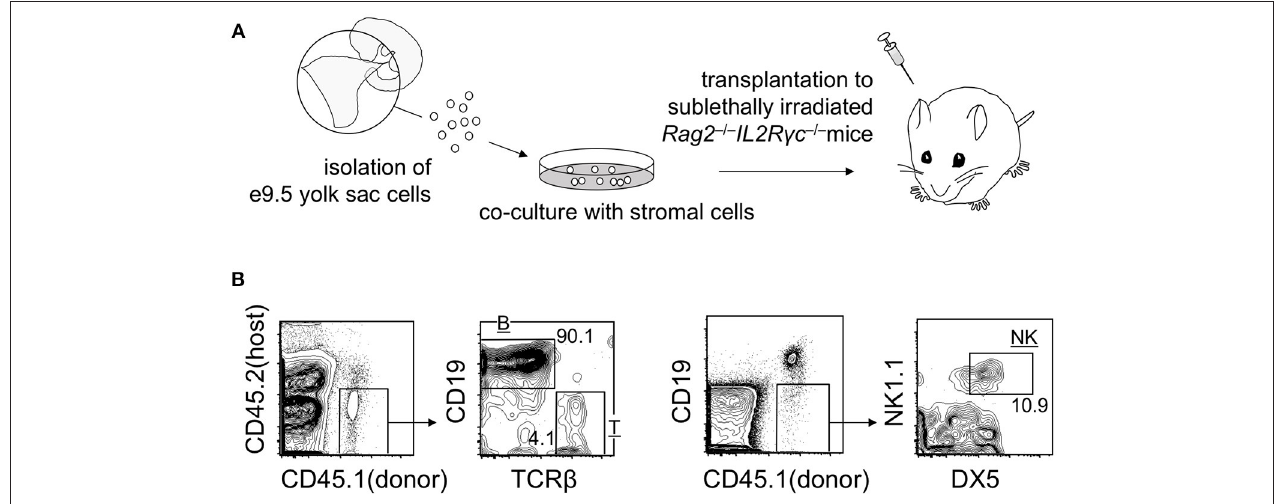
FIGURE 2 | Repopulation of lymphoid lineage cells by E9 yolk sac-derived cells. (A) Overview of the experimental procedure. (B) Representative flow cytometry plots showing T, B, and NK donor cell populations in the spleen at 3 weeks